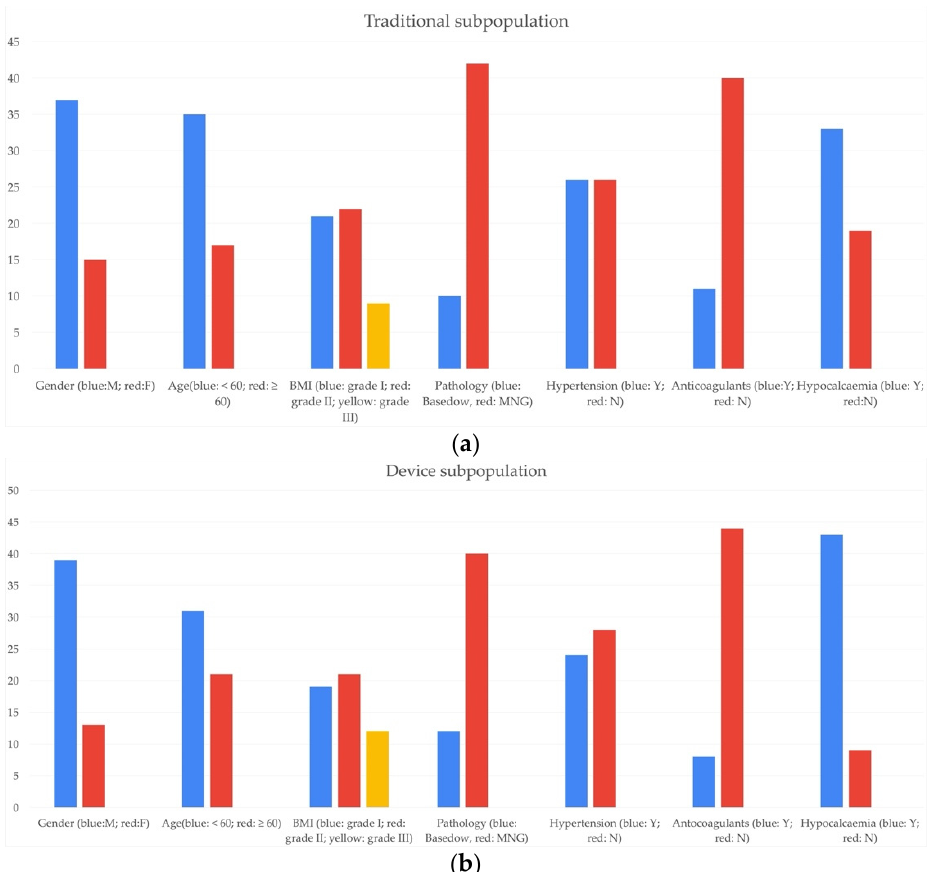
Figure 1. Demographic survey of ( a ) “Traditional” subpopulation and ( b ) “Device” subpopulation. In both figures, the y axis shows the number of patients.